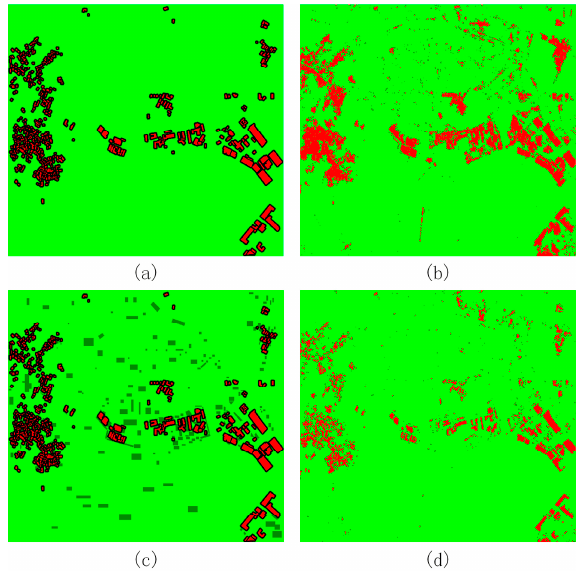
Figure 11. Sample selection and building extraction results. ( a ) is the samples from the true surface map; ( b ) is the result of building extraction using ( a ) samples; ( c ) consists of positive and negative samples (dark green); and ( d ) is the result of building extraction using ( c ) samples.